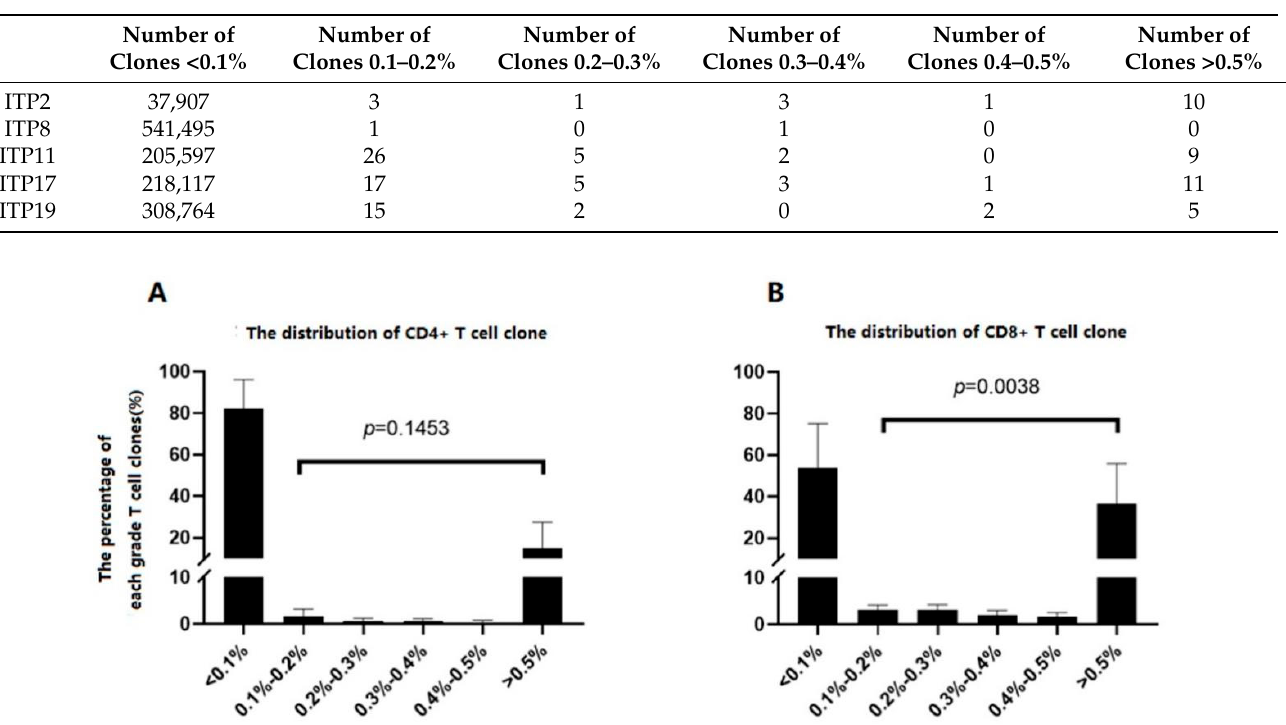
Table 3. The distribution of CD4 + T cell repertoire in peripheral blood before treatment. TCR of low frequency (<0.1% grade) accounted for (53.90% ± 21.30%) of the total TCR. The percentage of TCR of highest frequency (>0.5%) was higher than that of others ( p = 0.0038,